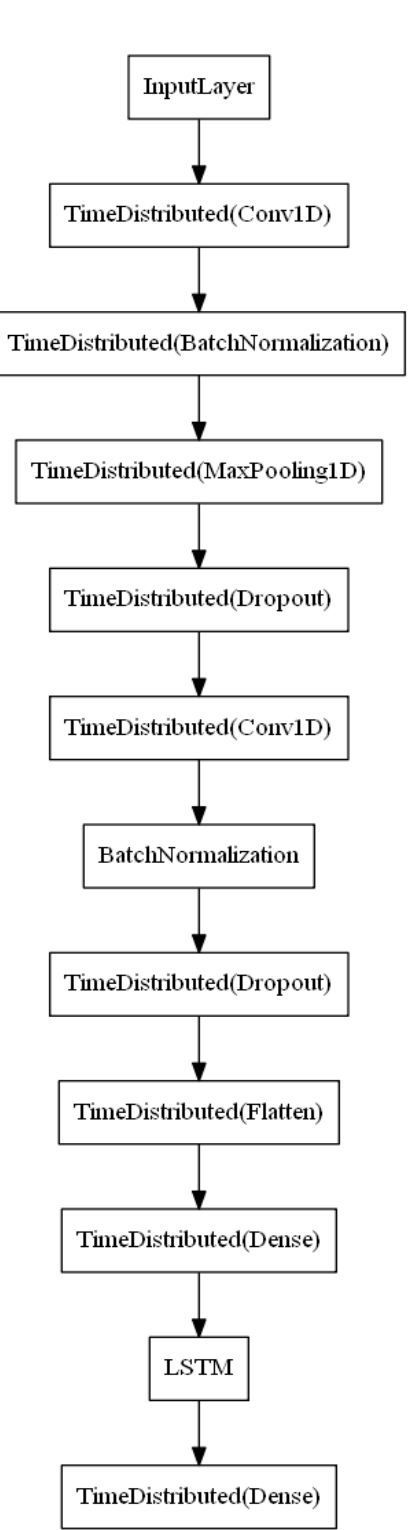
Figure 2. CNN-LSTM